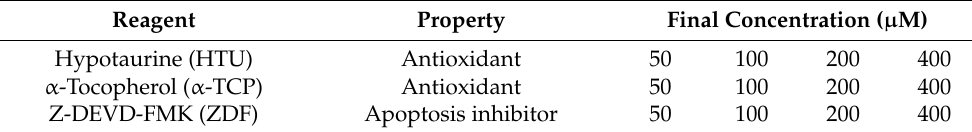
Table 2. Antioxidants and apoptosis inhibitor used for post-thaw